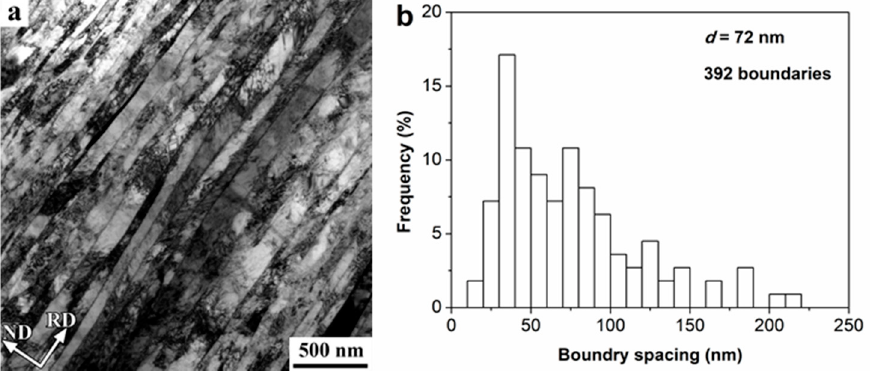
Figure 2. Microstructural characterization of the cold-rolled sample: ( a ) Representative TEM image; ( b ) The distribution of lamellar boundary spacing.